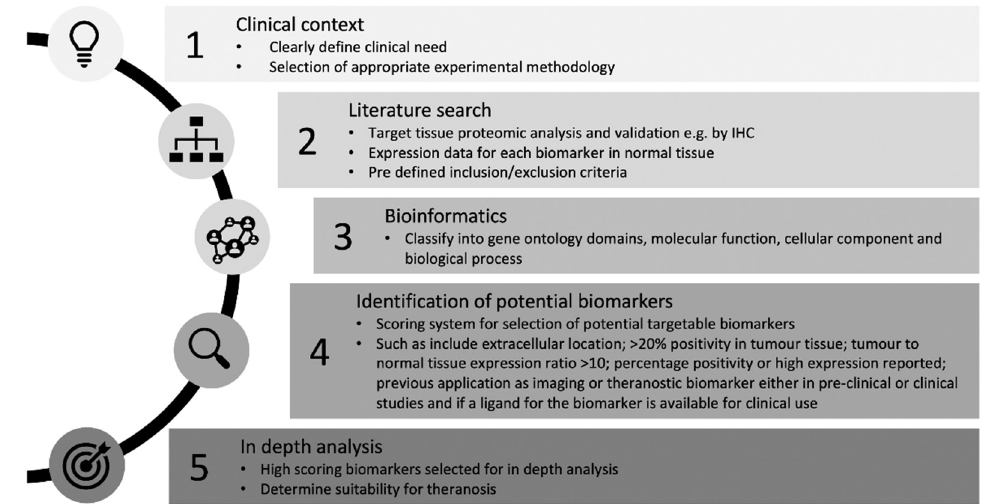
Figure 4. A blueprint to describe biomarker selection methodology for theranosis. A method of systematic review of the literature for the identification and selection of biomarkers for theranosis that is applicable to other cancers and disease